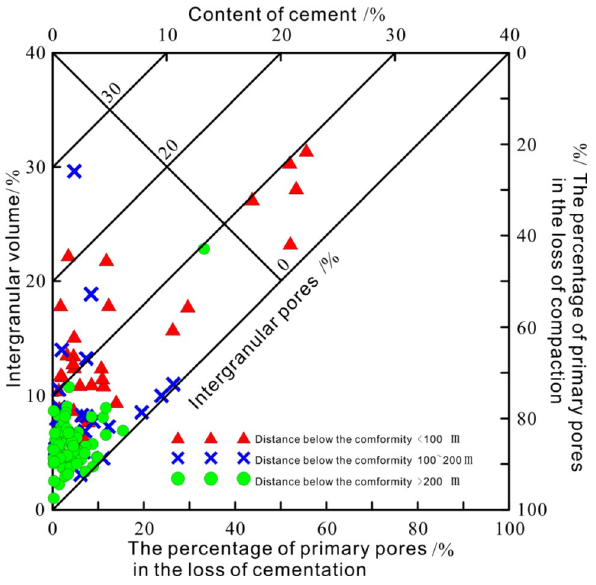
Fig. 10 Cementation–intergranular volume projection crossplot